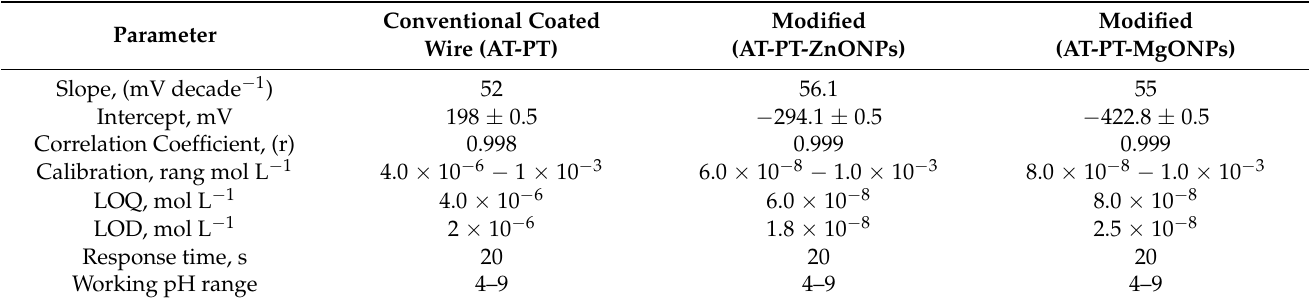
Table 1. The analytical characterization of the designed conventional coated wire AT-PT and modified (AT-PT-ZnONPs and AT-PT-MgONPs) sensors. Conventional Coated Parameter Wire (AT-PT)